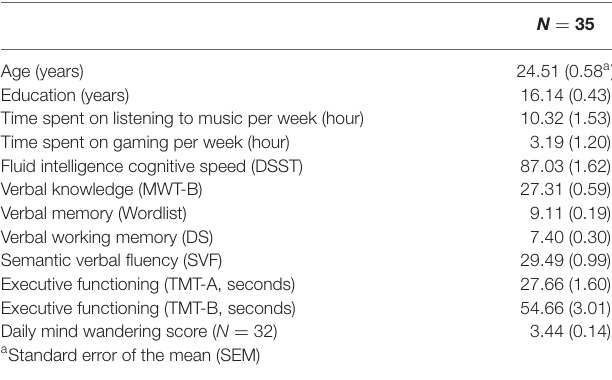
TABLE 1 | Sociodemographic information, characteristics of subjects and neuropsychological battery test